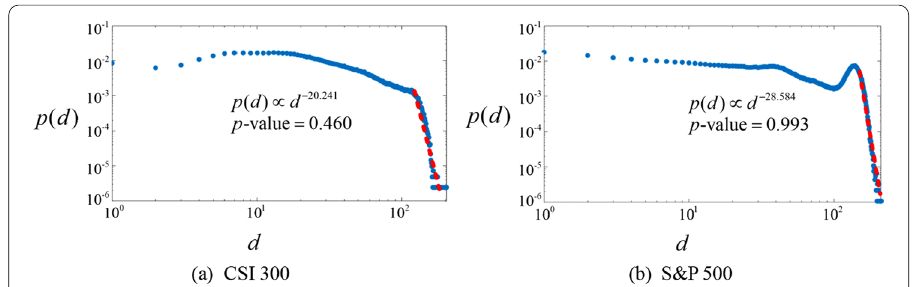
Fig. 6 Distribution of the link thickness in each stock set as well as the test